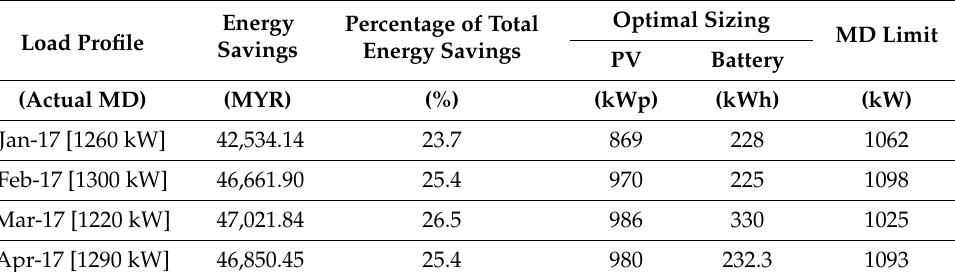
Table 12. GA optimization results for di ff erent load profiles.